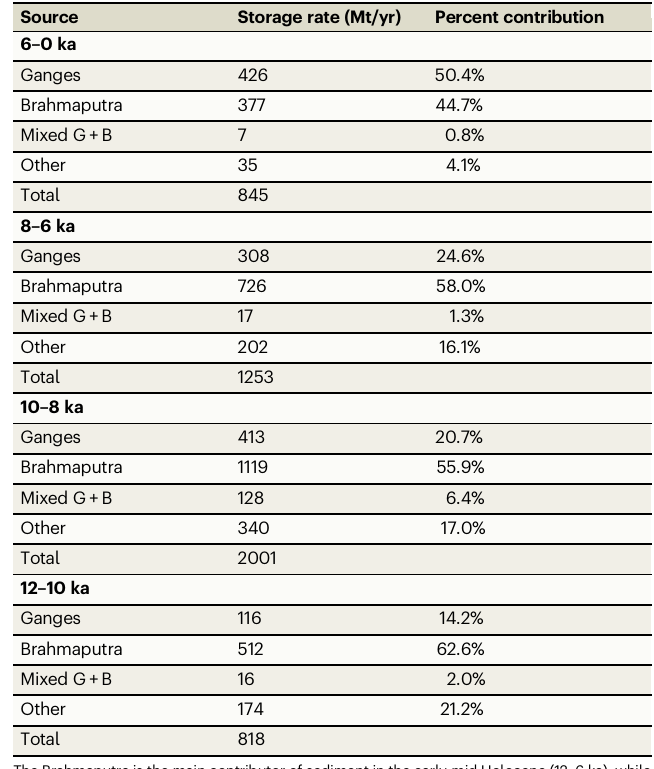
Table 2 | Average mass storage rates and percent contribu- tion for each river system through the Holocene